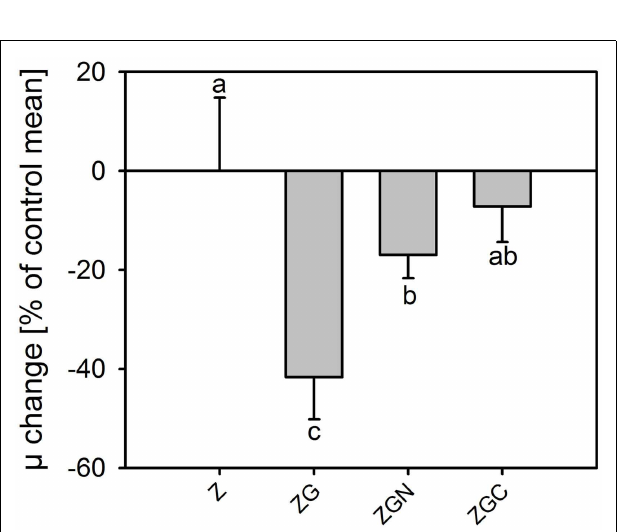
FIGURE 5 | Relative growth rates of Chlorella mirabilis under different nutrient treatments in the out-door micro-scale mass cultivation experiment . See Table 1 for treatment abbreviations (mean ± SD, n = 6). The same letter indicates homologous groups as recognized by theTukey HSD test at p = 0.05; the Z medium (control) is included in the group labeled “a.”